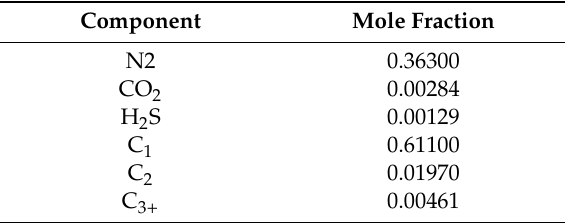
Table 1. Viscosity properties of the gas were given by the standard Lorentz–Bray–Clark model. All the basic properties of the gas with varying composition under reservoir conditions were determined using the above EOS and viscosity model. Table 1. Composition of original fluid (gas) in the Borz˛ecin